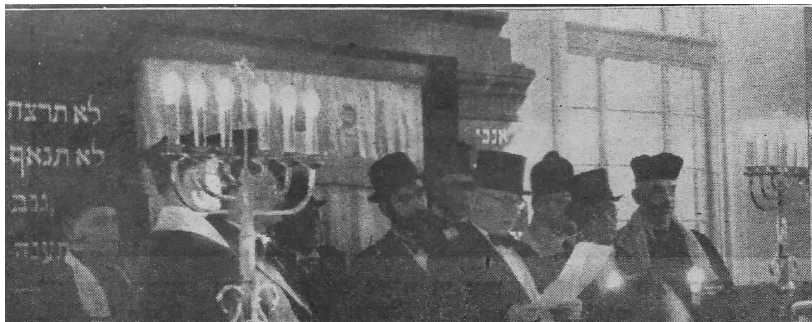
Figure 17. Inauguration of the Bulduri Synagogue, 14 August (Av 17) 1938. Yiddishe bilder 46 (18 November 1938).